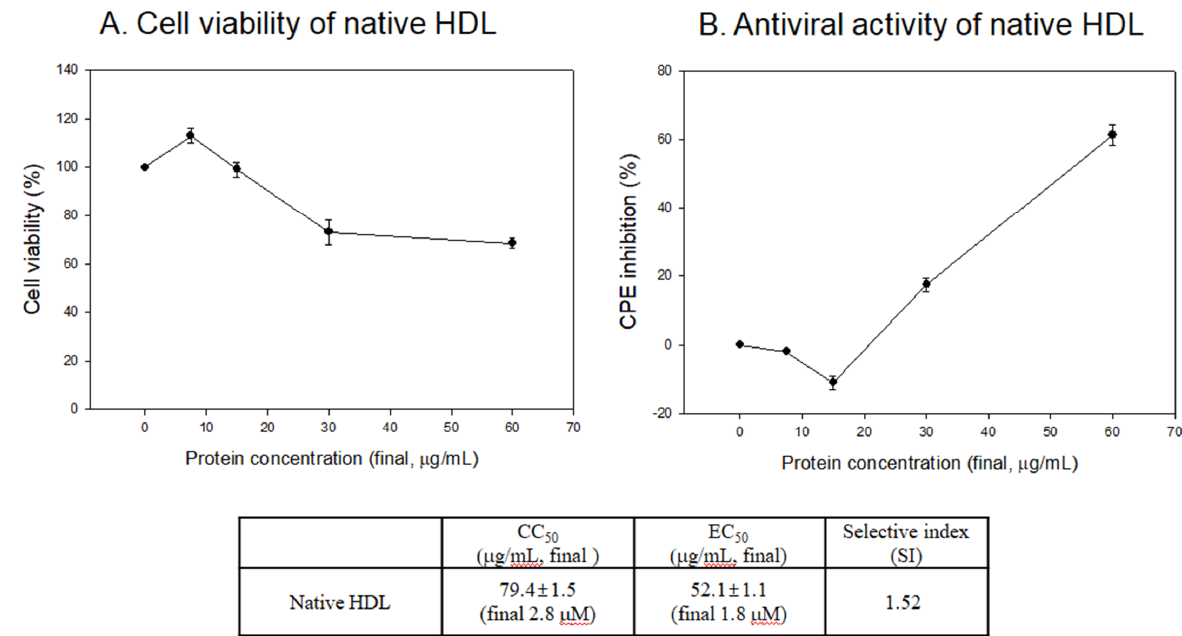
Figure 5. Vero E6 Cell viability ( A ) and cytopathic effect (CPE) reduction activity ( B ) of native HDL. EC 50 , effective concentration of compound needed to inhibit the CPE to 50% of control value. CC 50 , the cytotoxic concentration of the compound that reduced cell viability to 50%. SI, selectivity index = EC 50 /CC 50.